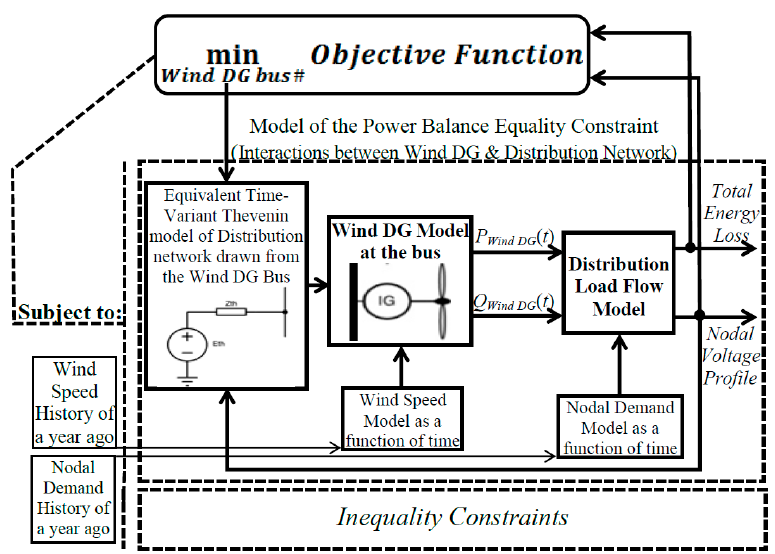
Figure 1. Schematic diagram of the wind energy based DG (WDG) placement problem definition and structure.